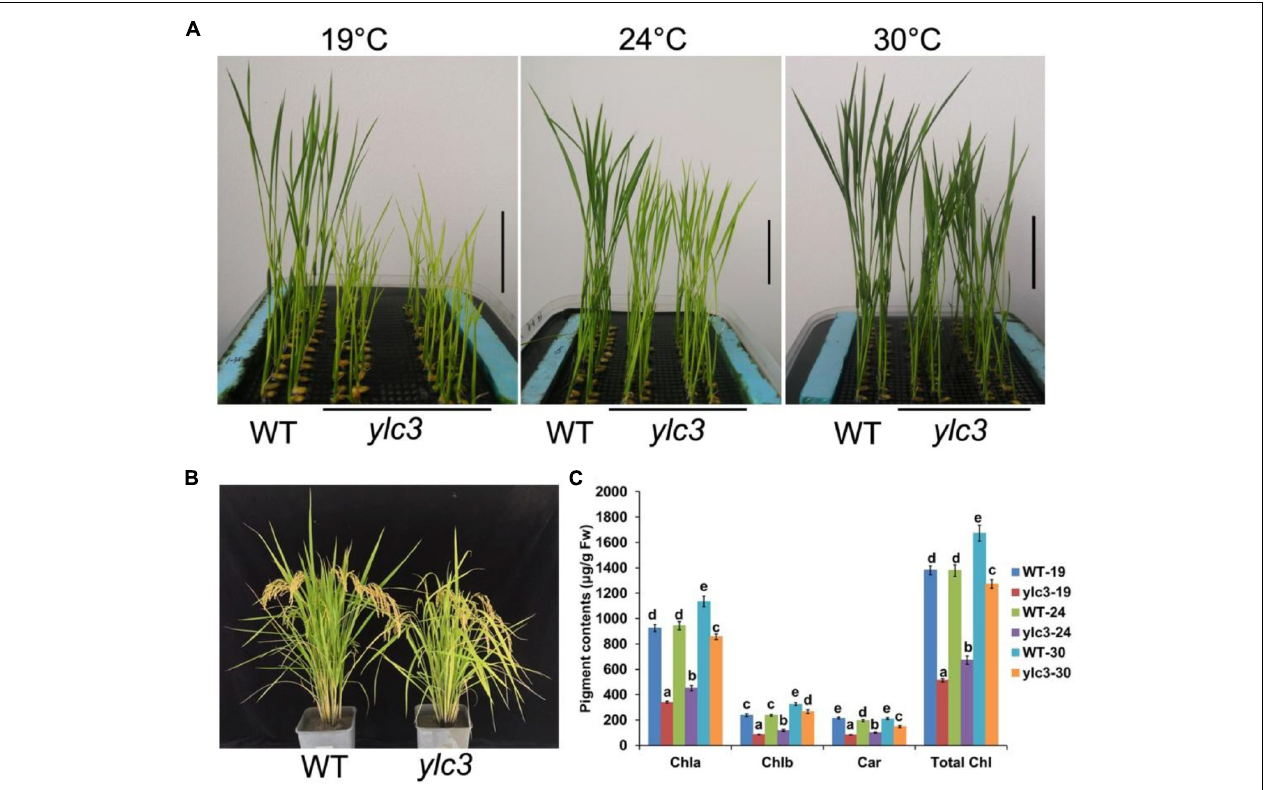
FIGURE 1 | Phenotypic analyses of ylc3 mutant. (A) Phenotypes of the WT and ylc3 seedlings (10-day-old) grown at different temperatures. Bar = 5 cm. (B) Heading stage. (C) Photosynthetic pigments of WT and ylc3 (10-day-old) grown at different temperatures ( ◦ C). Error bars represent SD ( n = 5). Bars with different letters indicate significant differences at P < 0.05,